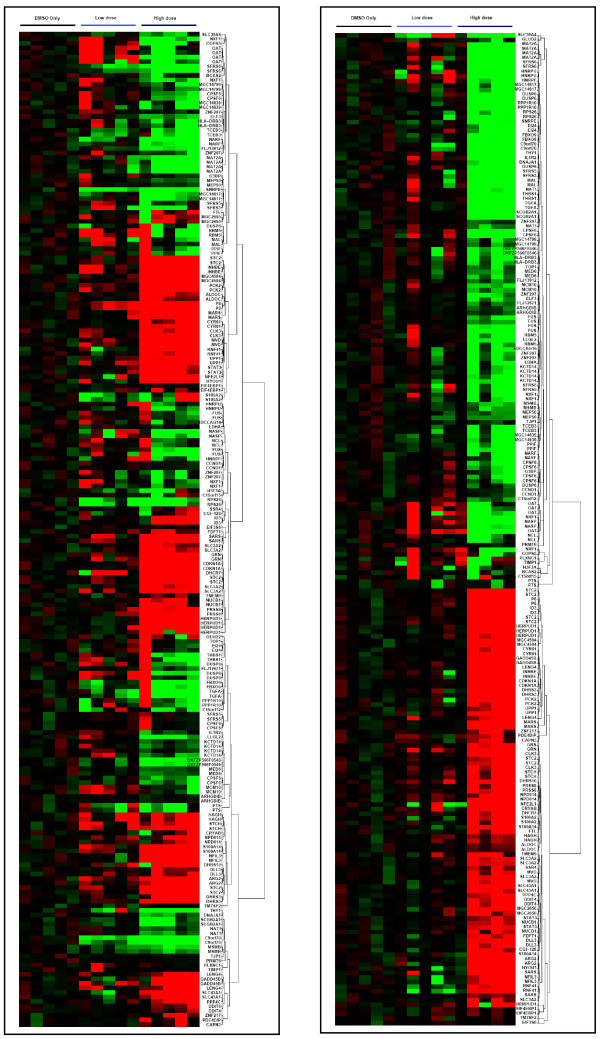
Genes identified as differentially expressed after treatment with high-dose (100 μM) fenofibrate. The plots show upregulation (red) and downregulation (green) of expression compared to DMSO control-treated cells. Cells were treated with 10 μM ("low dose") or 100 μM ("high dose") fenofibrate for 48 hours. Left – Normalised uncorrected data. Right – Data corrected using ICA-based filtering and removal of artefactual components. The data is improved but reveals an aberrant sample in the high-dose group (the first).